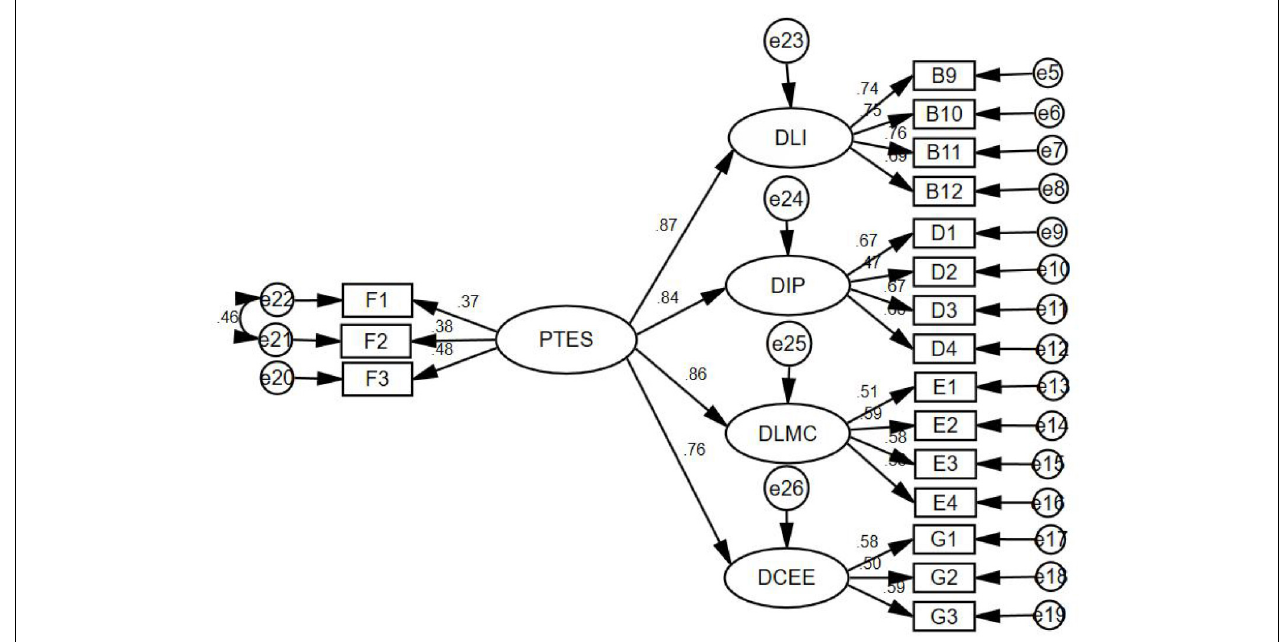
FIGURE 2 | Structure equation model (DLI, deep learning investment; DIP, deep information processing; DLMC, deep learning meta-cognitive; DCEE, deep cognitive emotional experience; PTES, perceived teacher emotional